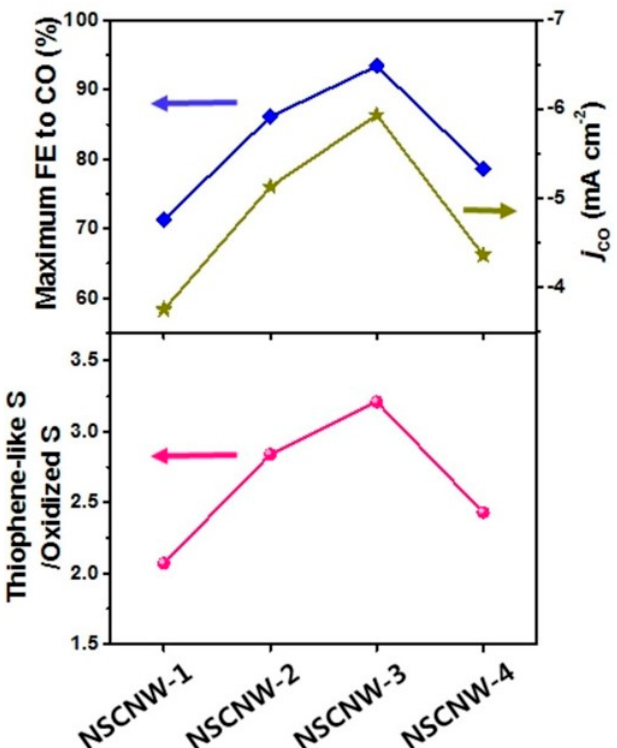
Figure 7. Correlation of the thiophene-like sulfur to oxidized sulfur ratio with the faradaic efficiencies to CO and current densities for several nitrogen and sulfur co-doped carbon nanoweb cathodes tested in the electroreduction of CO 2 , reproduced from [113], Copyright (2020), with permission from John Wiley and Sons.